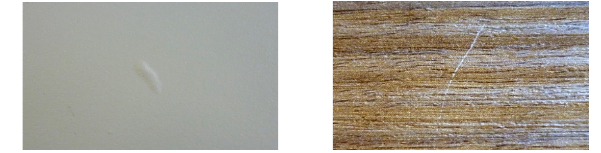
Fig. 3. Local deviation.